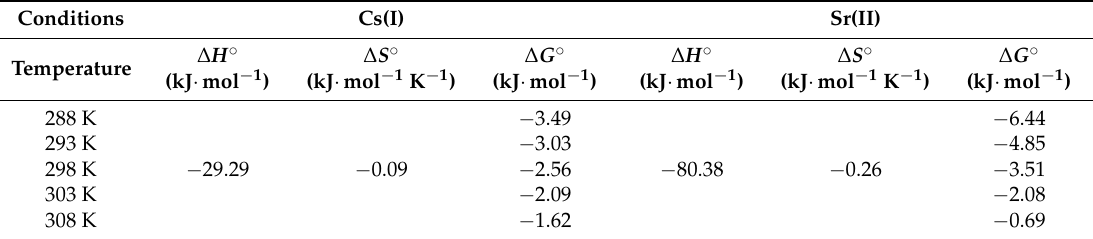
Table 2. Thermodynamic parameters of the solvent